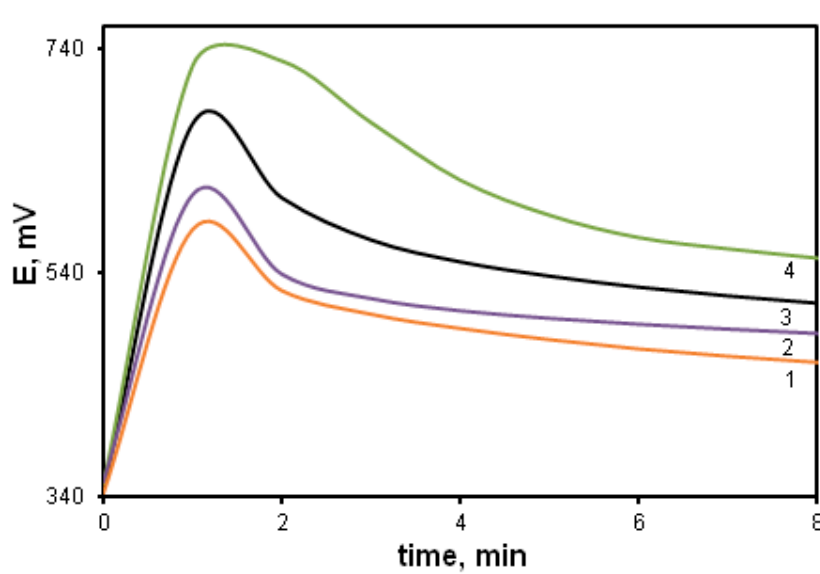
Figure 10. Time dependence of the redox potential during the DPDCB oxidation at different ratios of [Ox]/[DPDCB]: 0.5 (1), 0.75 (2), 1.25 (3), 3.75 (4).